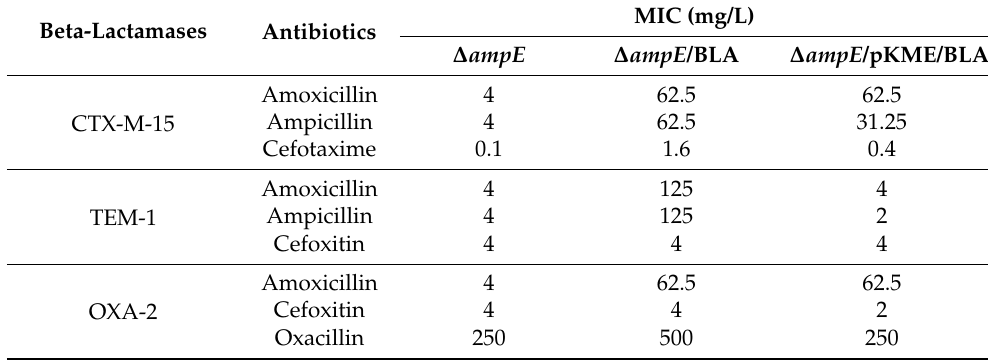
Table 5. Effect of AmpE on beta-lactamase expression ascertained by altered beta-lactam sensitivity.